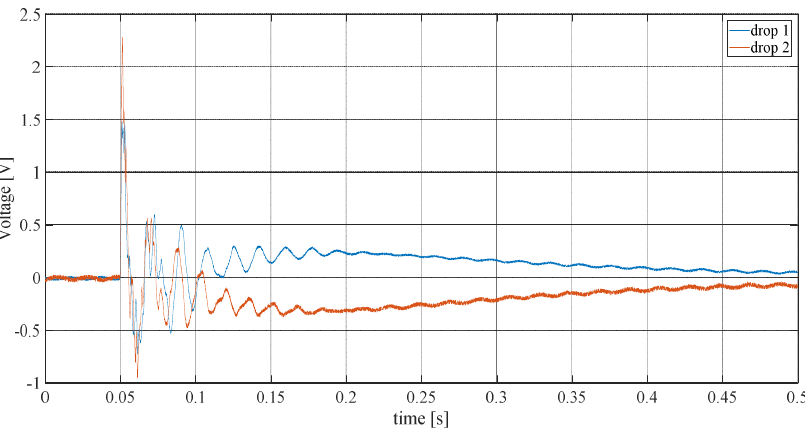
Figure 9. Voltage obtained for the bridge structure. Two raindrops were considered falling from 0.5 m, hitting the central point of the bridge.